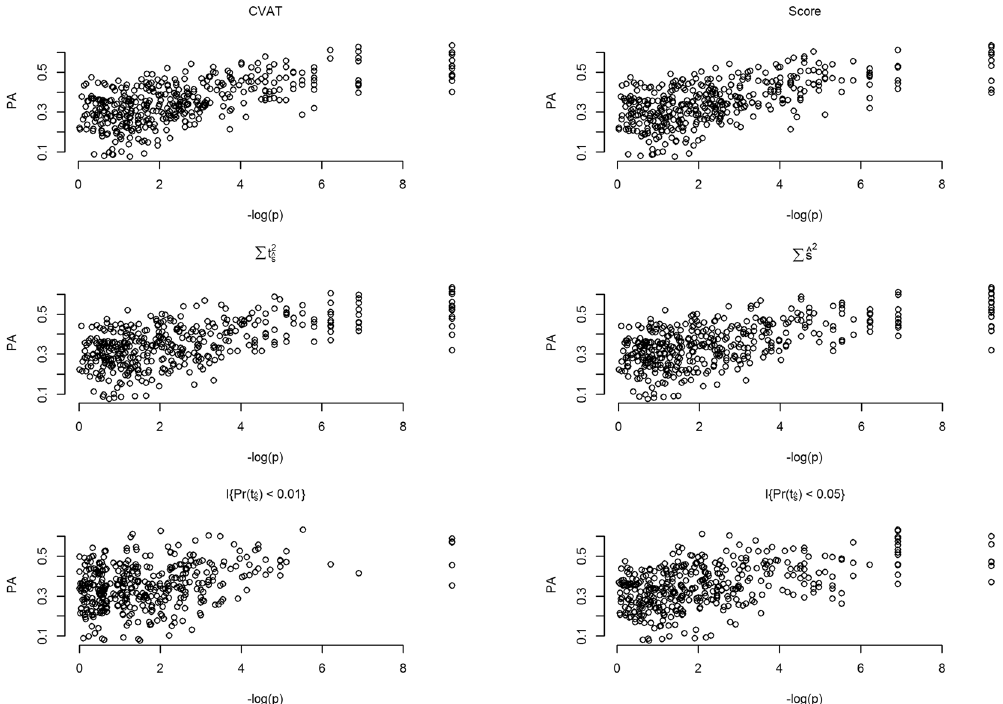
Figure 3. Relationship between the predictive ability of GFBLUP and significance levels of different set test statistics. Scatter plots showing the relationship between significance of set test statistics (x-axis) and predictive ability (PA, y-axis) of GFBLUP. Significance is expressed as − log(p). The different panels show results for the different set test statistics: T CVAT (CVAT), T Score (Score), T Sum using single marker effects ∑ ^ ( s ) 2 or using single marker t-statistics ∑ ^ ( t ) s2 , and T Count with a threshold p-value < 0.05 < . < . ˆ (I{Pr(t ) 0 01})